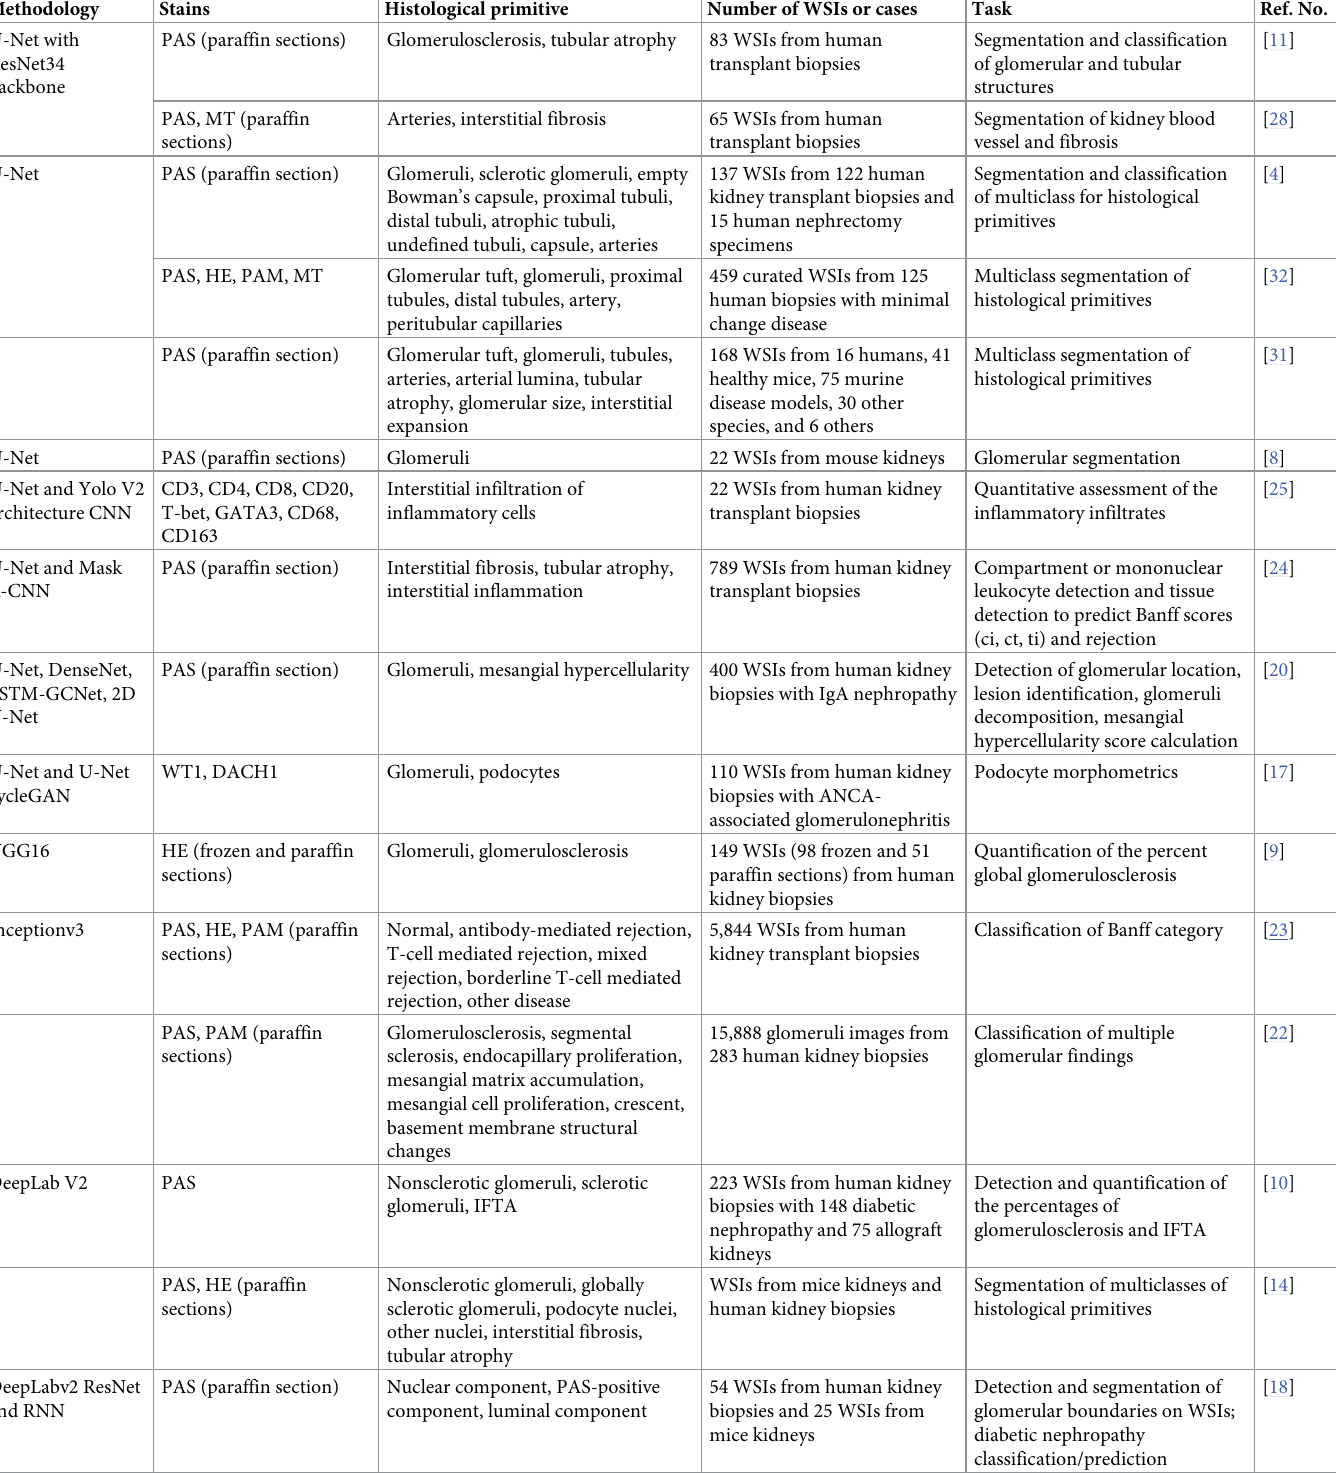
Table 1. Deep learning methodologies used for renal pathological studies.